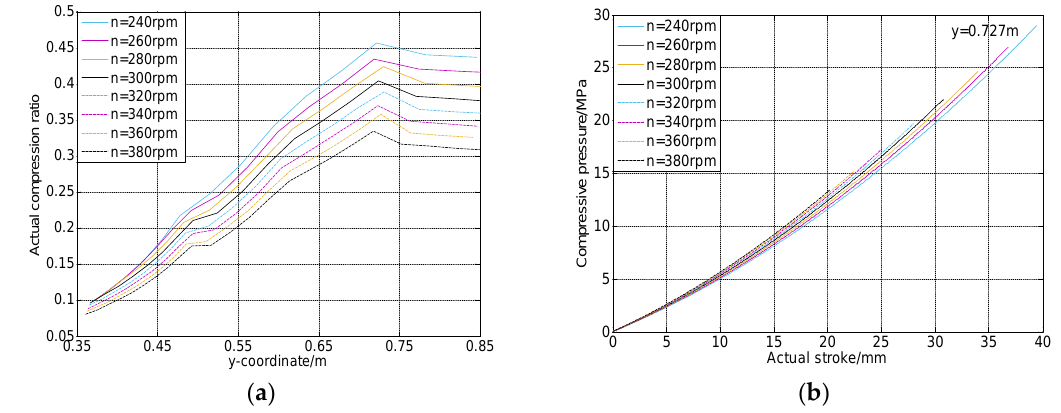
Figure 5. Compression ratio and pressure for various speeds: ( a ) relation of compression ratio vs. the height of mantle; ( b ) relation of compressive pressure vs actual stroke.